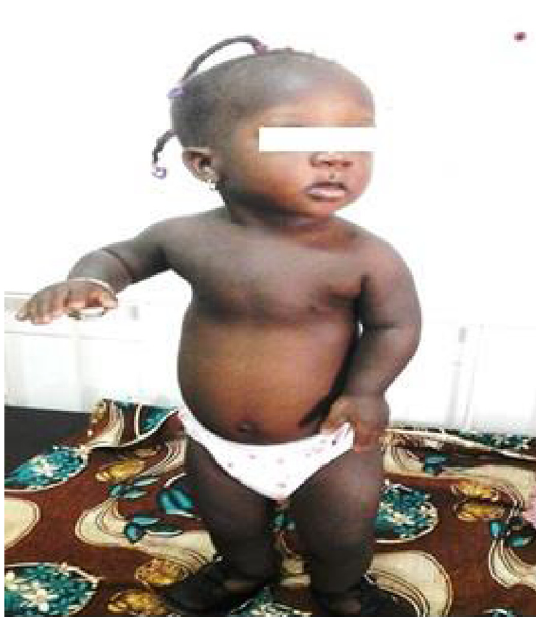
Fig. 1. General features of the child.